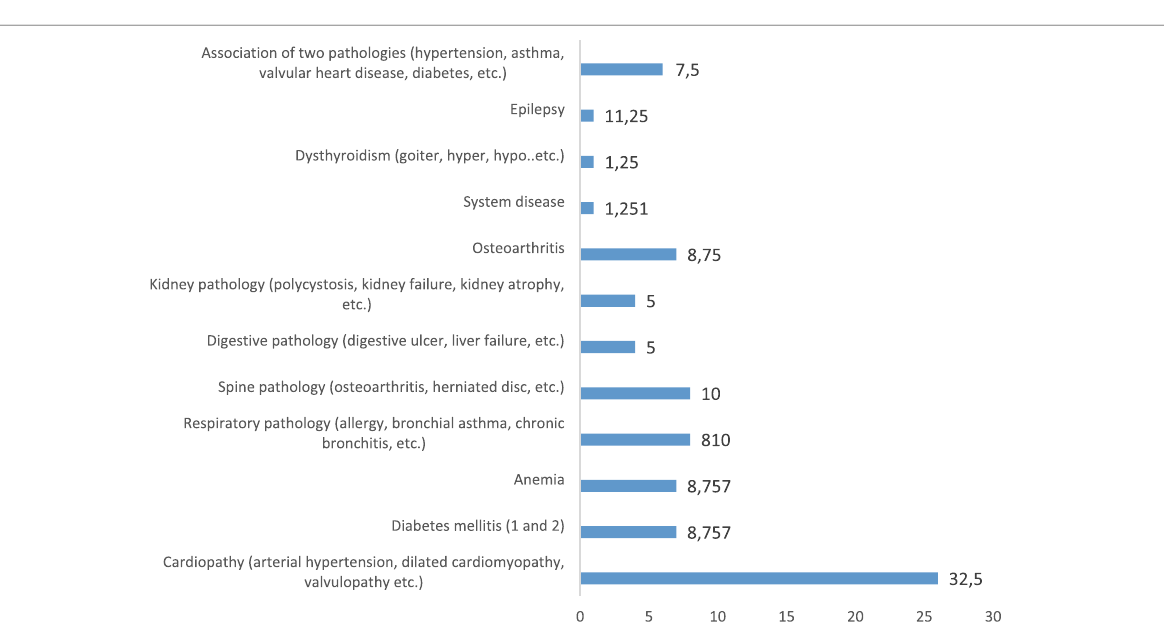
Fig. 3 The type of general pathology reported by the women examined and their respective frequencies in our study population ( N